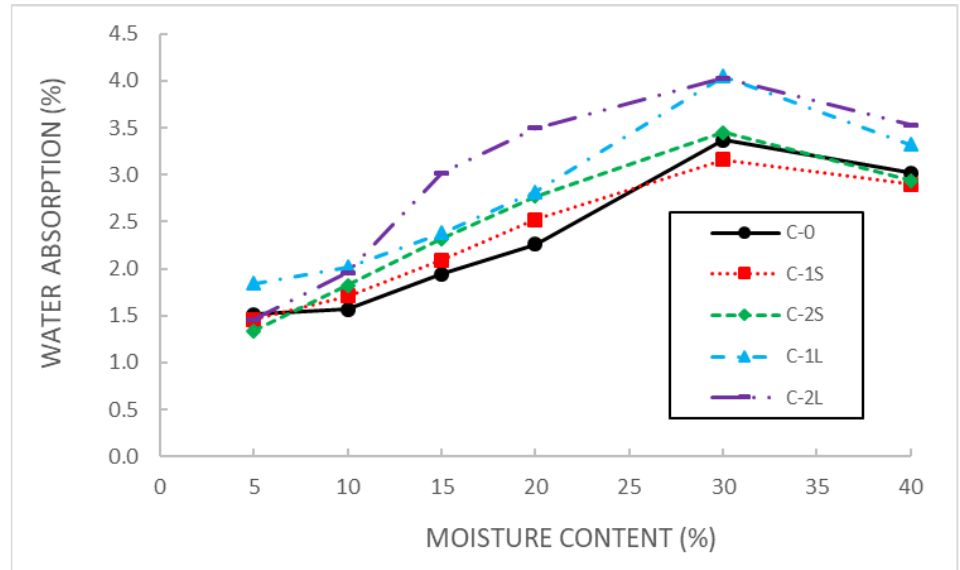
Figure 6. Water absorption.